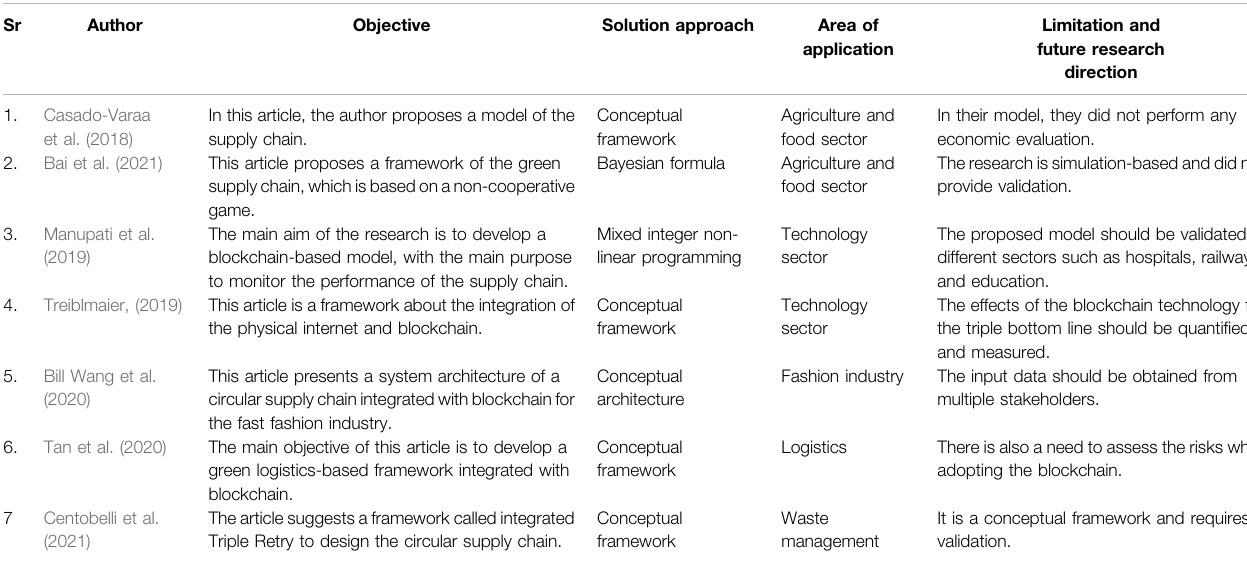
TABLE 6 | Models and frameworks related to the blockchain-based green/circular supply